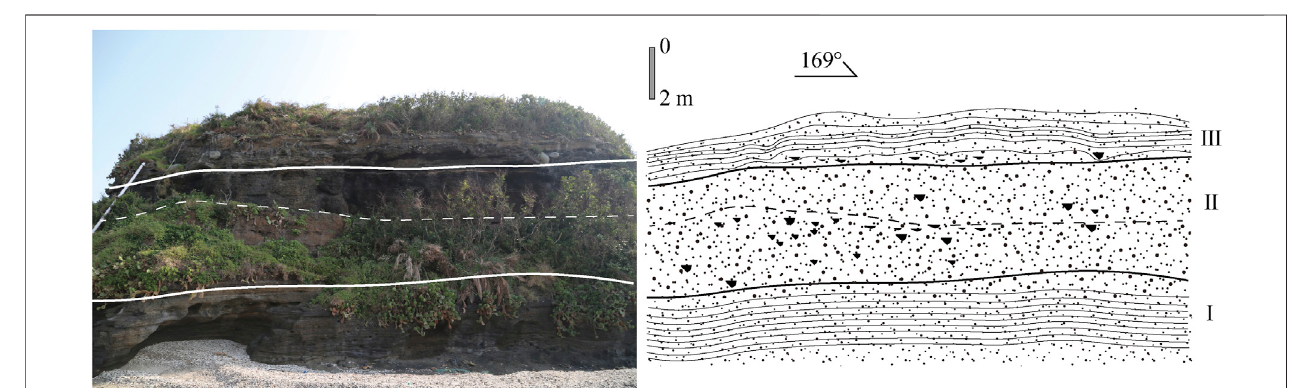
FIGURE 8 | Stratigraphic log at Zhuzai